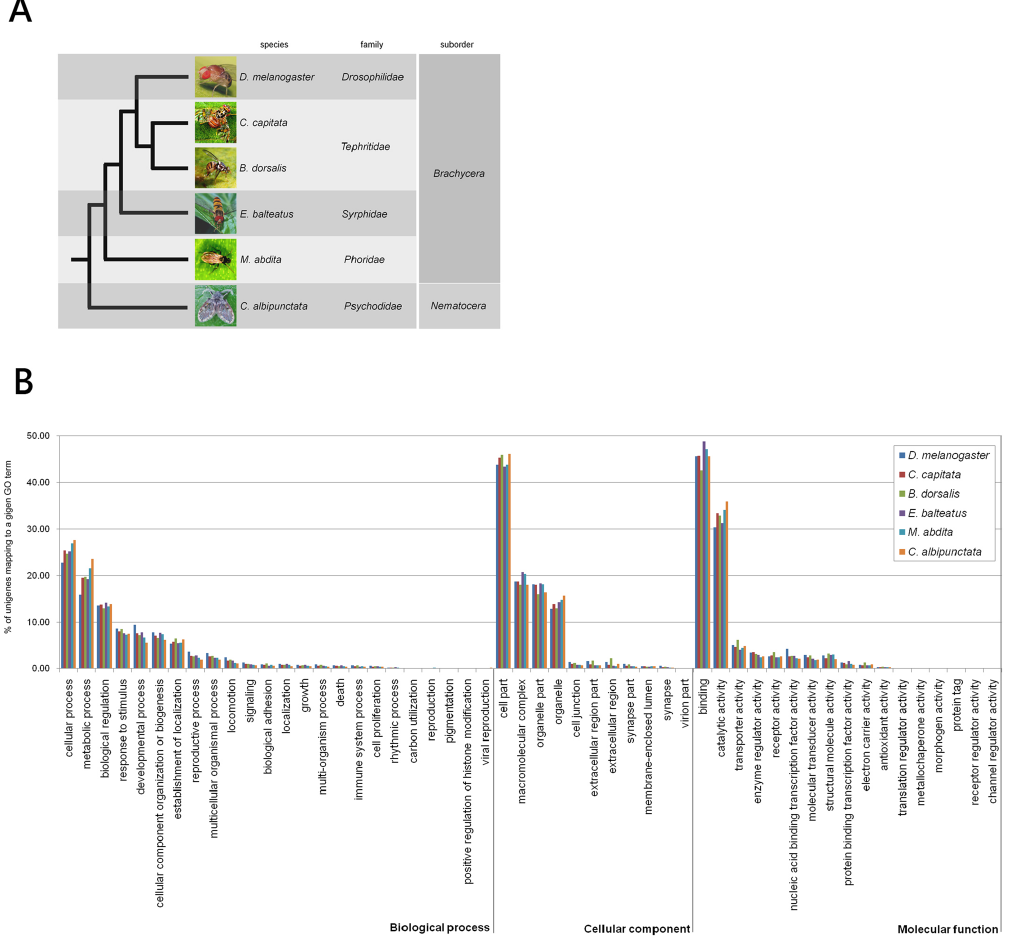
Figure 4. Comparative analysis of GO term distribution in dipteran embryonic transcriptome. (A) A schematic phylogenetic tree of the species included in the comparison of GO term distribution. Families and sub-orders are indicated. The analyzed species span approximately 200 million of years of evolution of the order Diptera [38,102]. (B) Column heights represent the percentage of the annotated unigene in each assembly assigned to a give GO term, level 2. The relative percentage of unigenes included in each GO categories are comparable among all the analysed